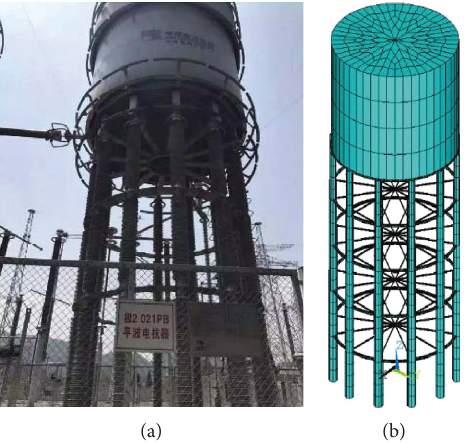
Figure 7: UHV smoothing reactor. (a) Site scene of the equipment and (b) finite element model.